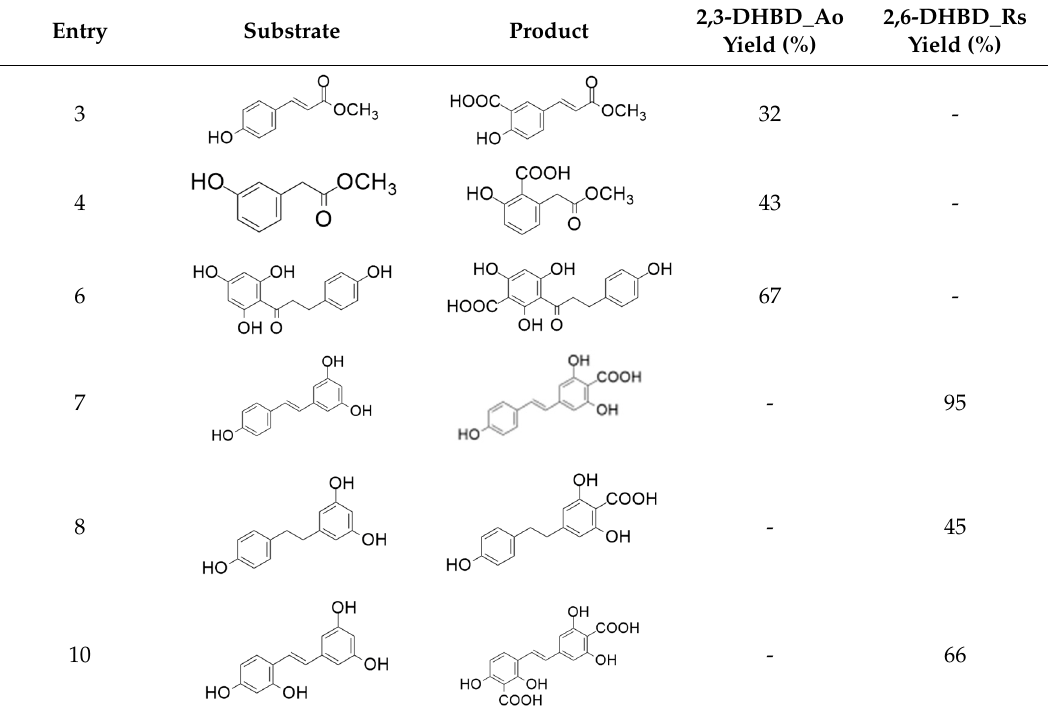
Table 5. Carboxylation of phenols and polyphenols under preparative conditions. Adapted with permission from [61]. Copyright 2017, John Wiley and Sons.